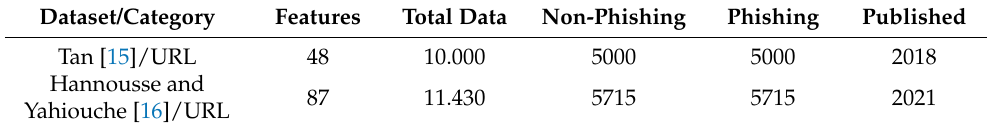
Table 1. Dataset